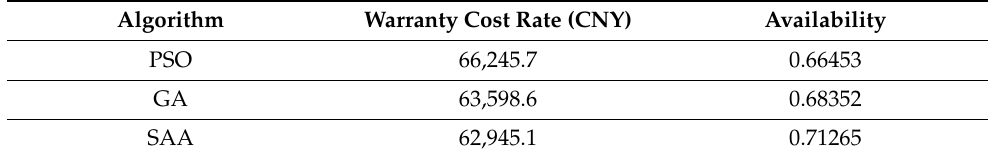
Table 2. The results of each